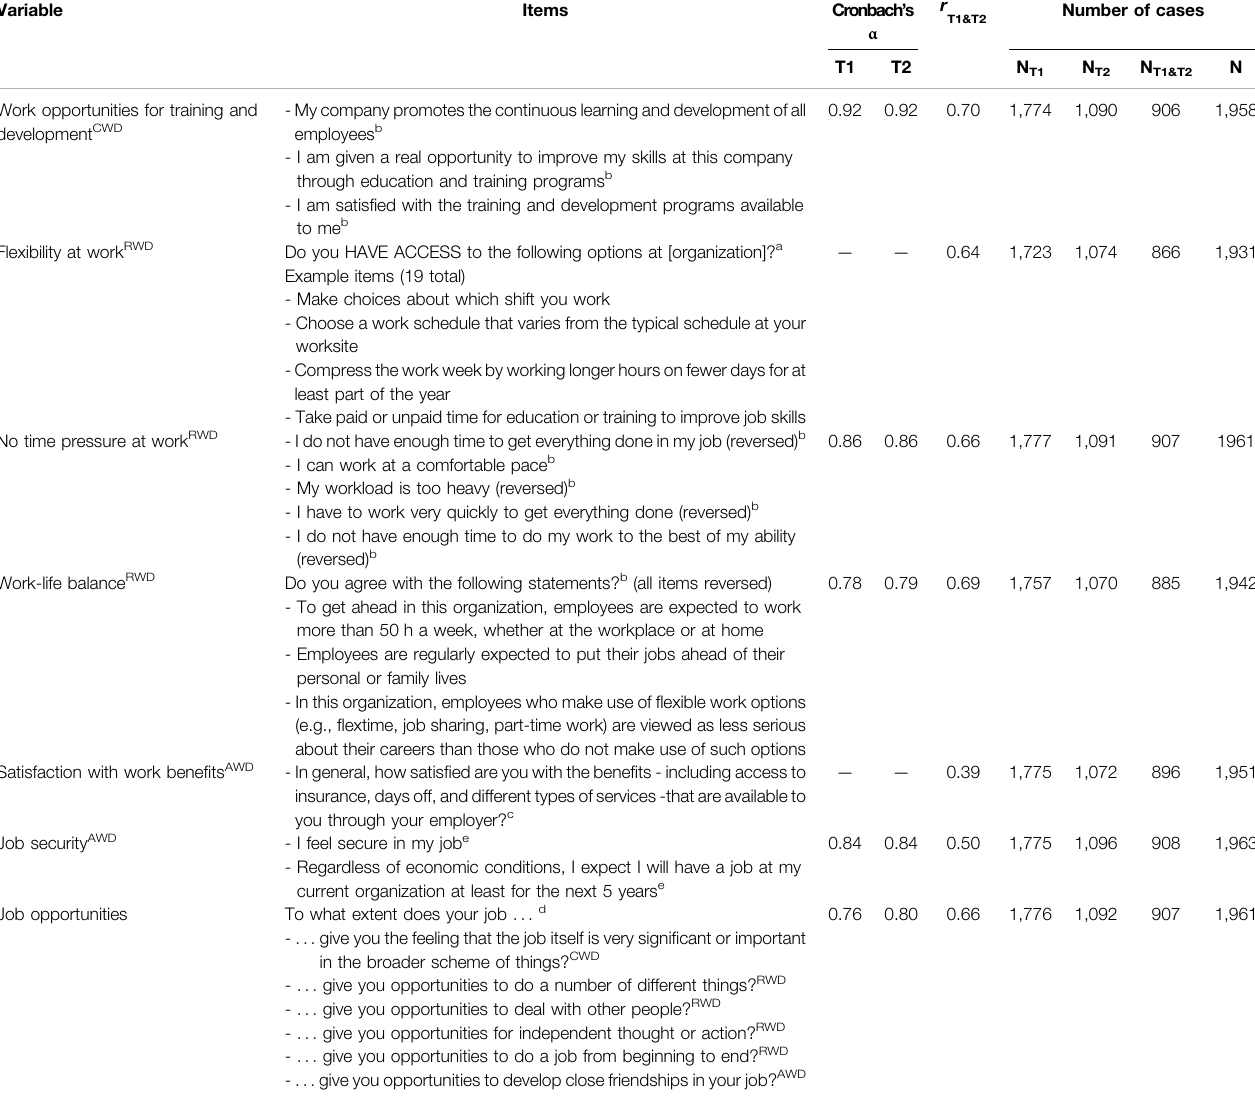
TABLE 2 | Assessment of wise